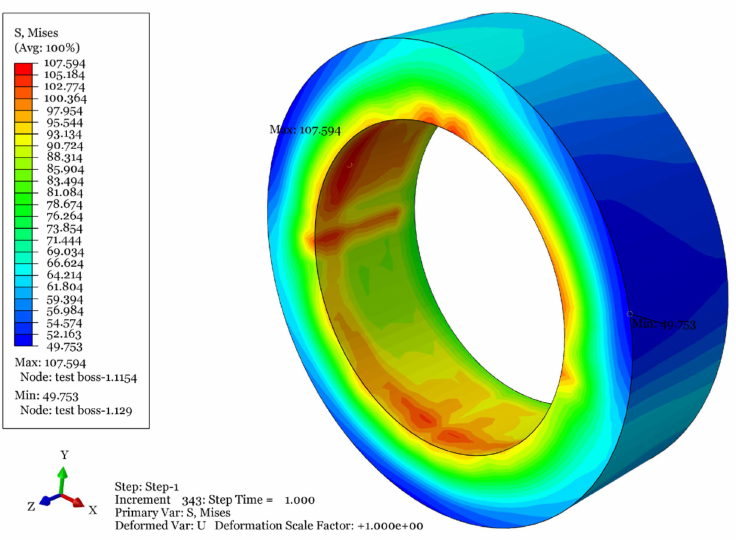
Figure 12. The von Mises stress distribution in the test boss resulted from 200 Nm torque.